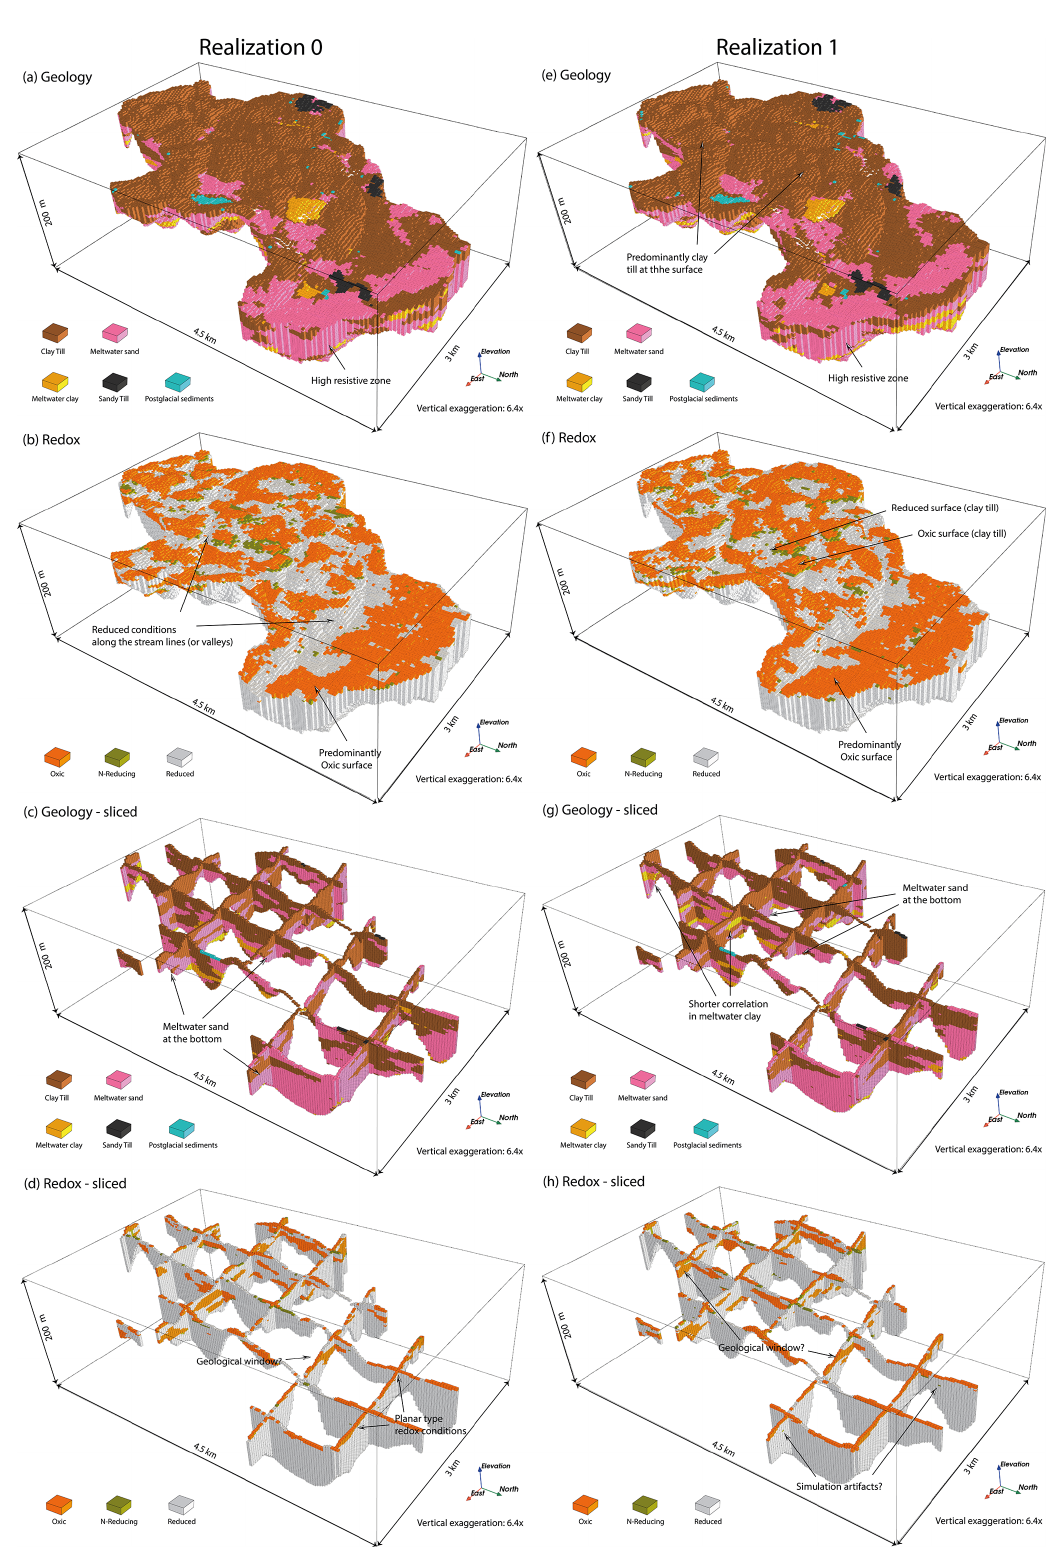
Figure 13. Two conditioned realizations from the posterior model. (a, b) One realization of jointly simulated geology and redox. (c, d) The same realization sliced in the X and Y directions. (e–h) Same figure configuration as in (a–d) but for a different realization.